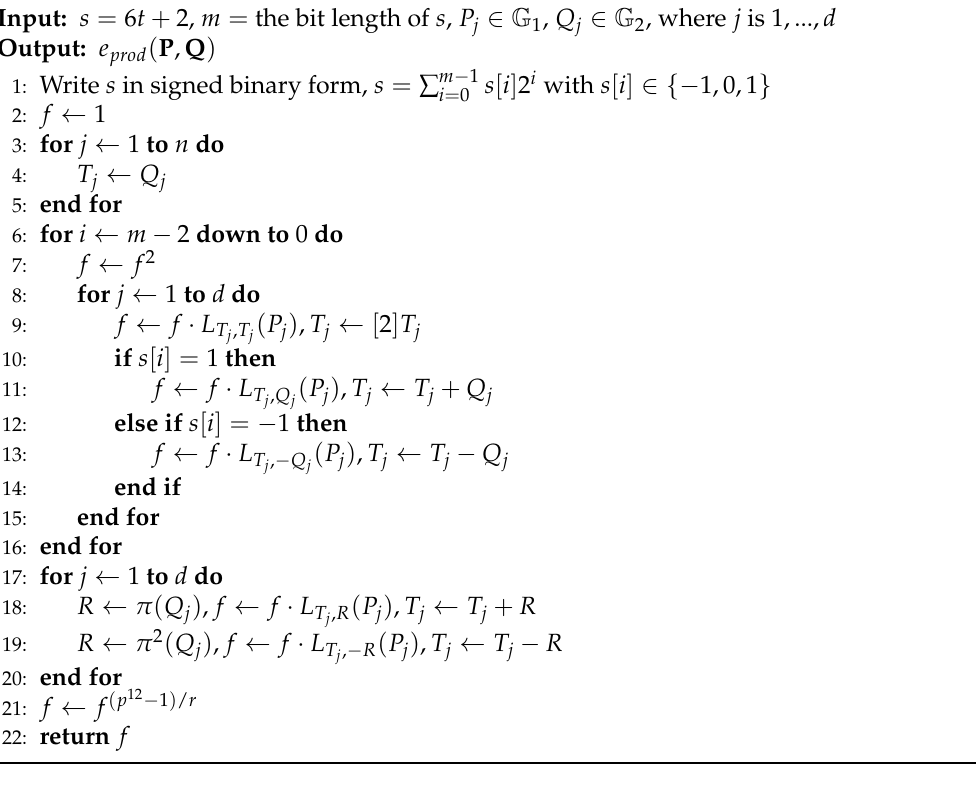
Algorithm 3 Fixed-Q